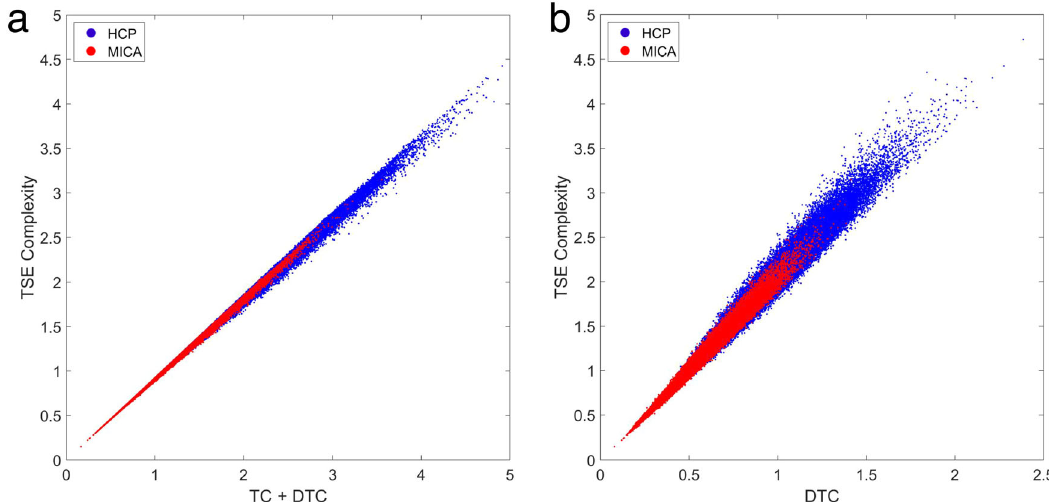
Fig. 2 Approximating TSE complexity with total correlation and dual total correlation. Data are from 100,000 randomly selected subsets of 10 nodes (blue: HCP data; red: MICA data), with TSE complexity computed exactly, by sampling all subsystems. a Sum of TC + DTC versus TSE complexity; HCP: R = 0.998, p = 0; MICA: R = 0.999, p = 0. b DTC versus TSE; HCP: R = 0.982, p = 0; MICA: R = 0.992, p =